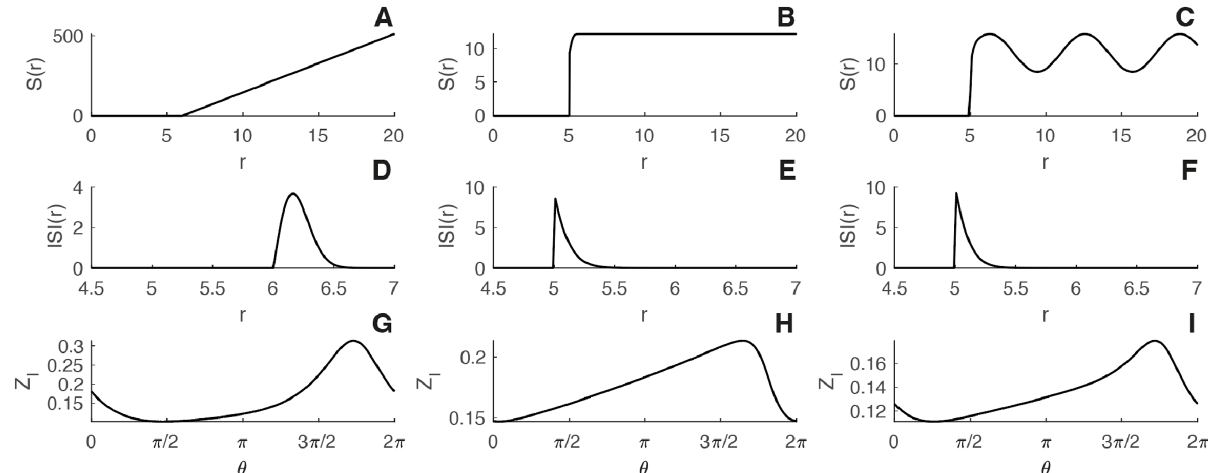
Fig 4. Macroscopic phase-resetting curve and hazard rate. The figure gives the hazard rate function (top panels) together with the resulting mPRC for an excitatory network (bottom panels). A-C) Hazard rate functions. D-F) ISI densities. G-I) Solution of the mPRC (6). Parameters: A-D-G) S ( h , r ) = exp( h ) H ( r − T ref ) ε ( r − T ref )), I ext = 2.5 mV , T ref = 6 ms , τ s = 10 ms , J s = 4 mV . ms , ε = 3 and Δ t = 0.05 ms . B-E-H) S ( h , r ) = exp( h ) H ( r − T ref ) tanh(exp( h )( r − T ref )), I ext = 2.5 mV , T ref = 5 ms , τ s = 10 ms , J s = 3 mV . ms and Δ t = 0.05 ms . C-F-I) S ( h , r ) = exp( h ) H ( r − T ref ) tanh(exp( h )( r − T ref )) (1 + ε cos( ωr )), I ext = 2.5 mV , T ref = 10 ms , τ s = 3 ms , τ = 5 ms , J s = 15 mV . ms , ε = 3, ω = 1 and Δ t = 0.05 ms . On panels A-B-C) and D-E-F) the hazard rate function and corresponding ISI densities are plotted for h =